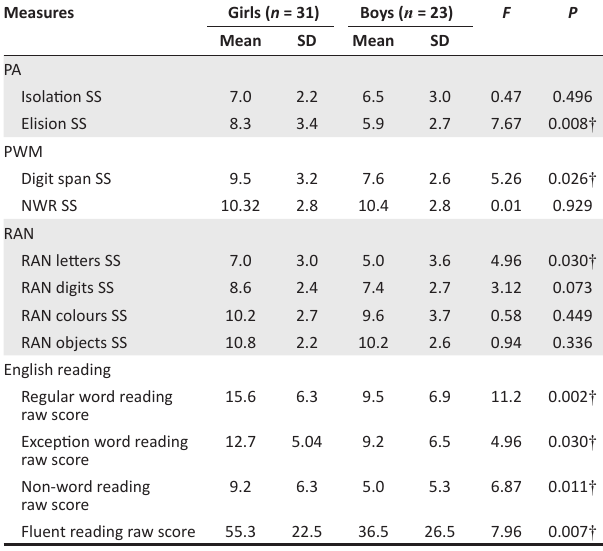
TABLE 1 : Means, standard deviations and test statistics obtained for girls and boys on phonological processing and reading measures.